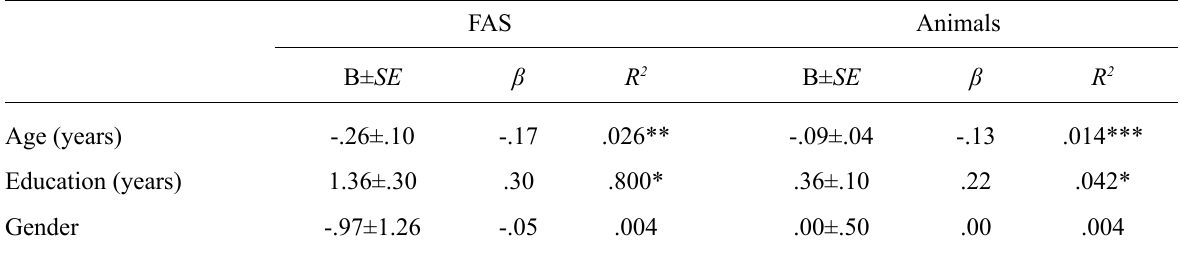
Multiple Linear Regression Analysis for the Variables Education, Age and Gender on Verbal Fluency Tasks